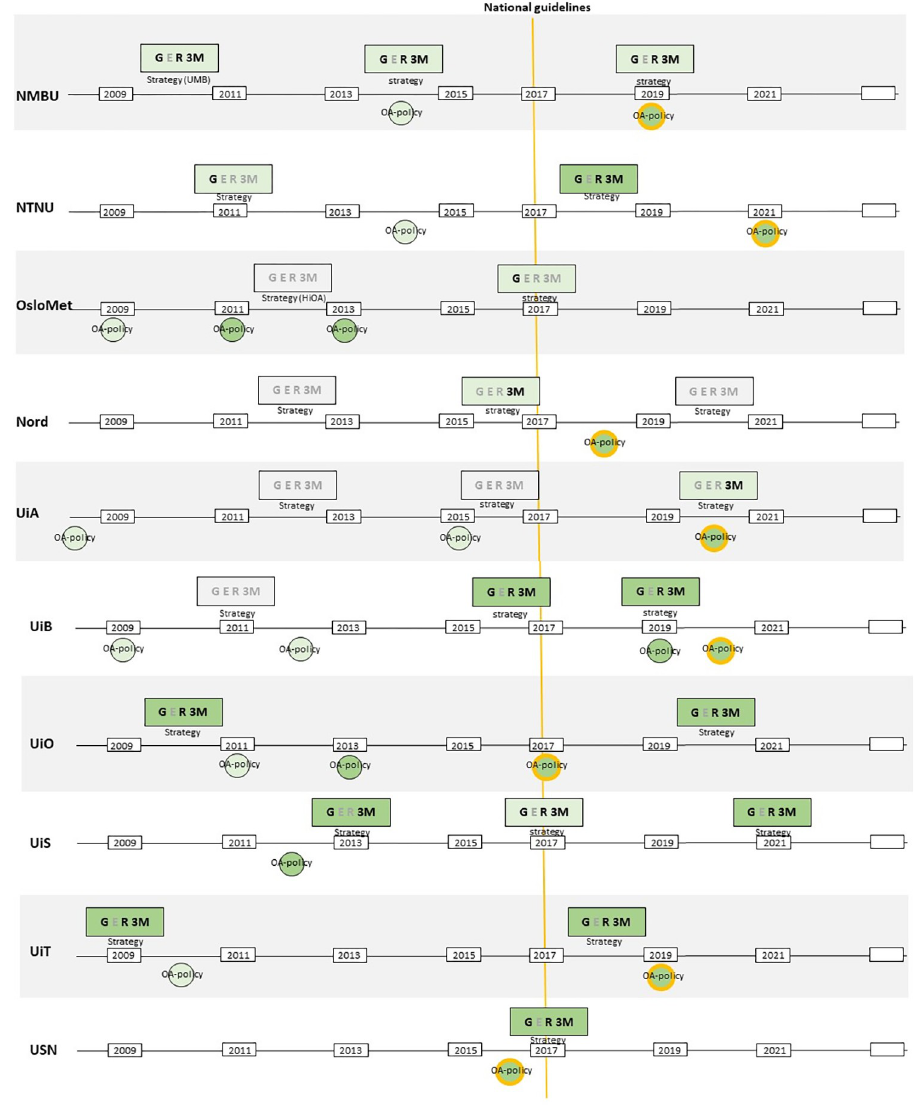
Fig 1. Summary of the development of the ten Norwegian universities’ strategies and policies. Summary of the development of the Norwegian universities’ strategies and policies. Dashed vertical line indicates when National guidelines were introduced in 2017. Colour grading is used to indicate level of emphasis of open access with grey (low), light green (medium) and green (high). Letters signify G = General open access, E = Open access connected to education, R = Open access connected to research, 3M = Open access connected to the third